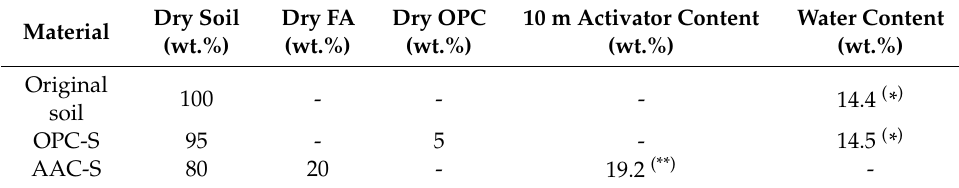
Table 3. Composition of the materials tested.